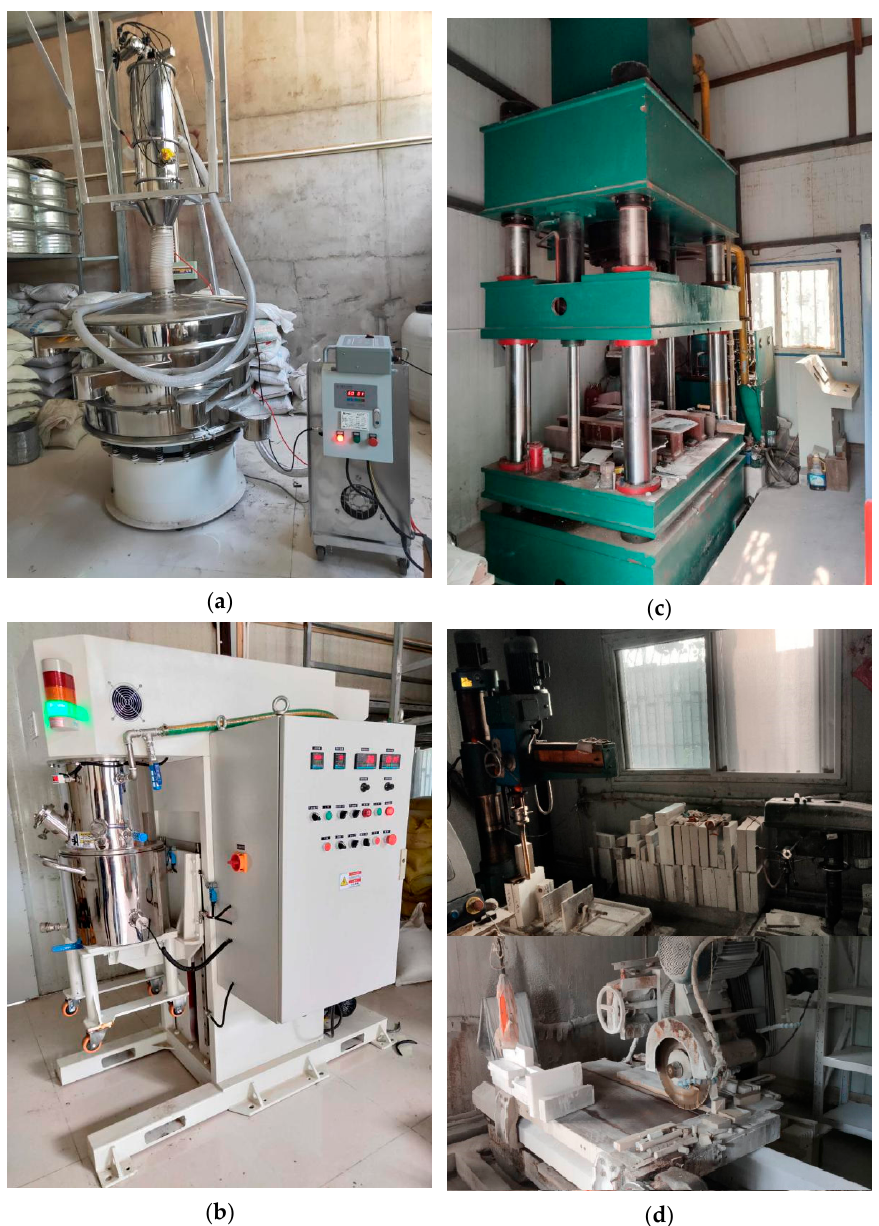
Figure 4. Equipment for making synthetic sandstone: ( a ) mechanical sieve with an automatic feeder; ( b ) 20 L mechanical mixer; ( c ) 500-ton hydraulic press; ( d ) coring drill/table saw.